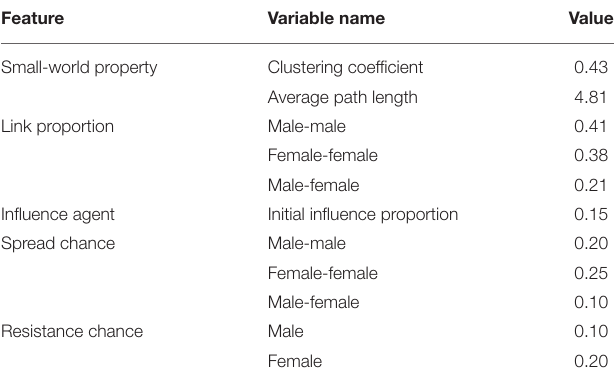
TABLE 1 | Overview of parameters used for the social network